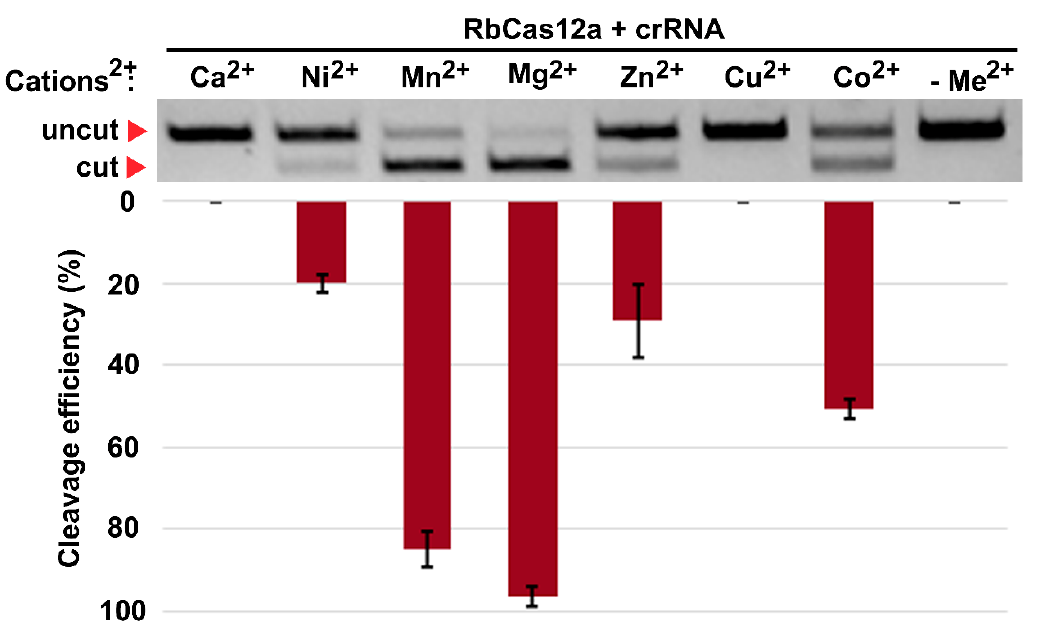
Figure 2 . Effect of divalent cations on RbCas12a cleavage activity. Mean cleavage efficiencies and standard deviations calculated from three independent experiments of Me 2+ -dependent in vitro cleavage reactions are shown. Reactions in the same buffer but without any Me 2+ addition served as controls.